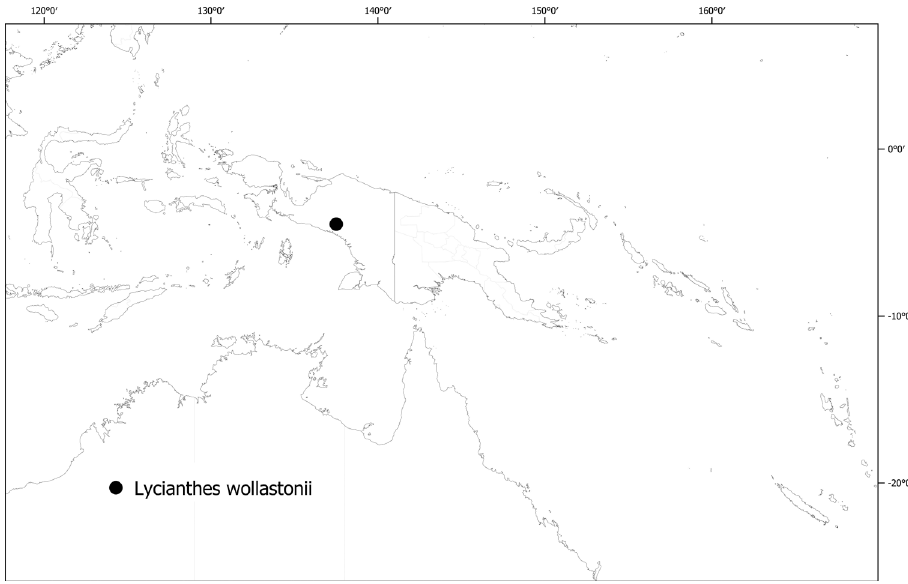
Figure 56. Distribution of Lycianthes wollastonii